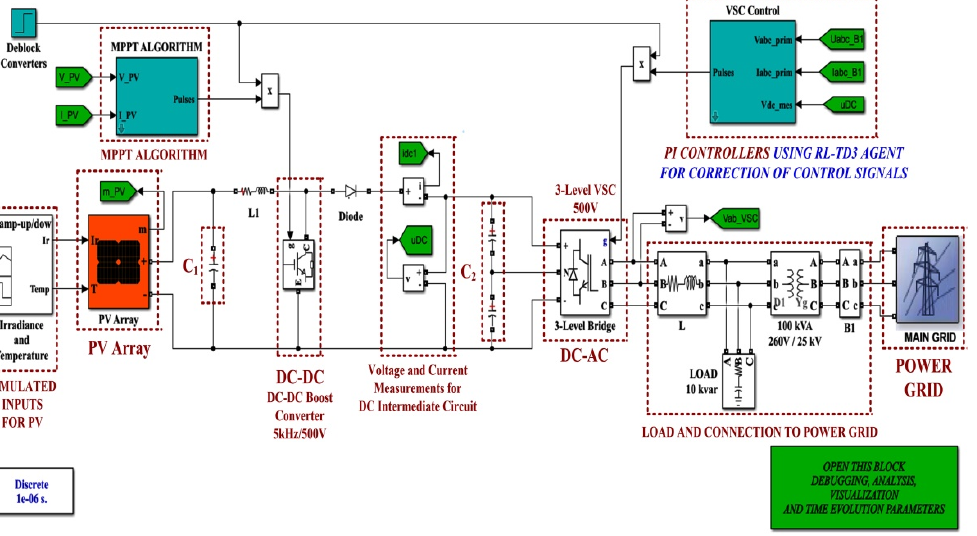
Figure 5. The model MATLAB Simulink implementation of the control system for the GC-PV array based on PI-type controllers using an RL-TD3 agent for the correction of control signals.